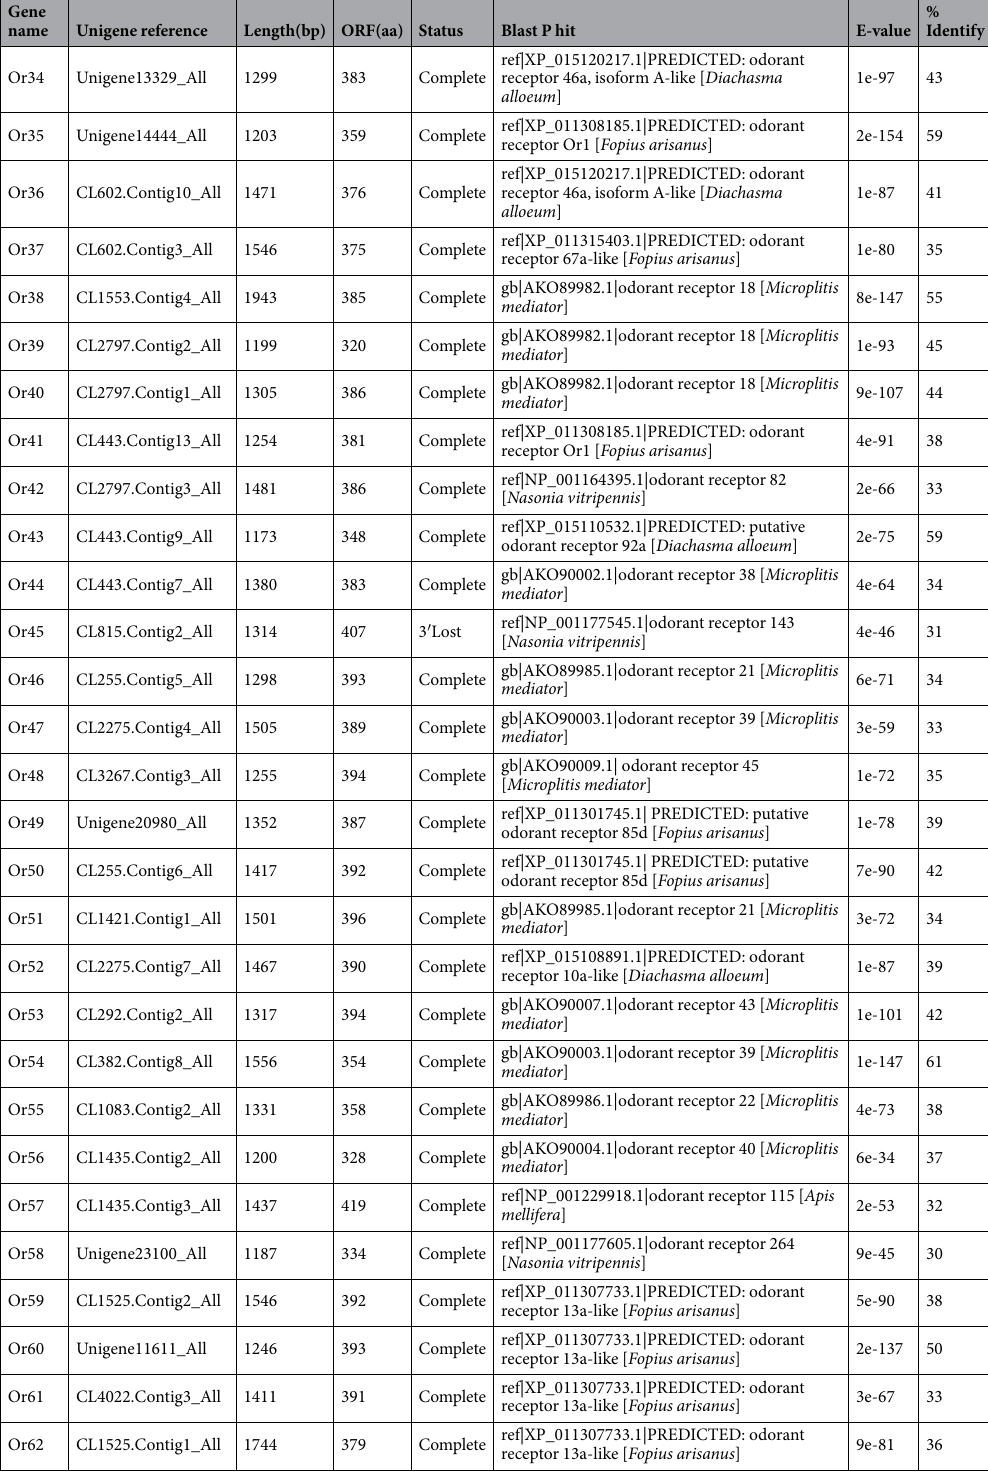
Table 1. Candidate odorant receptor transcripts identified in adult male and female A . gifuensis antennal transcriptomes.